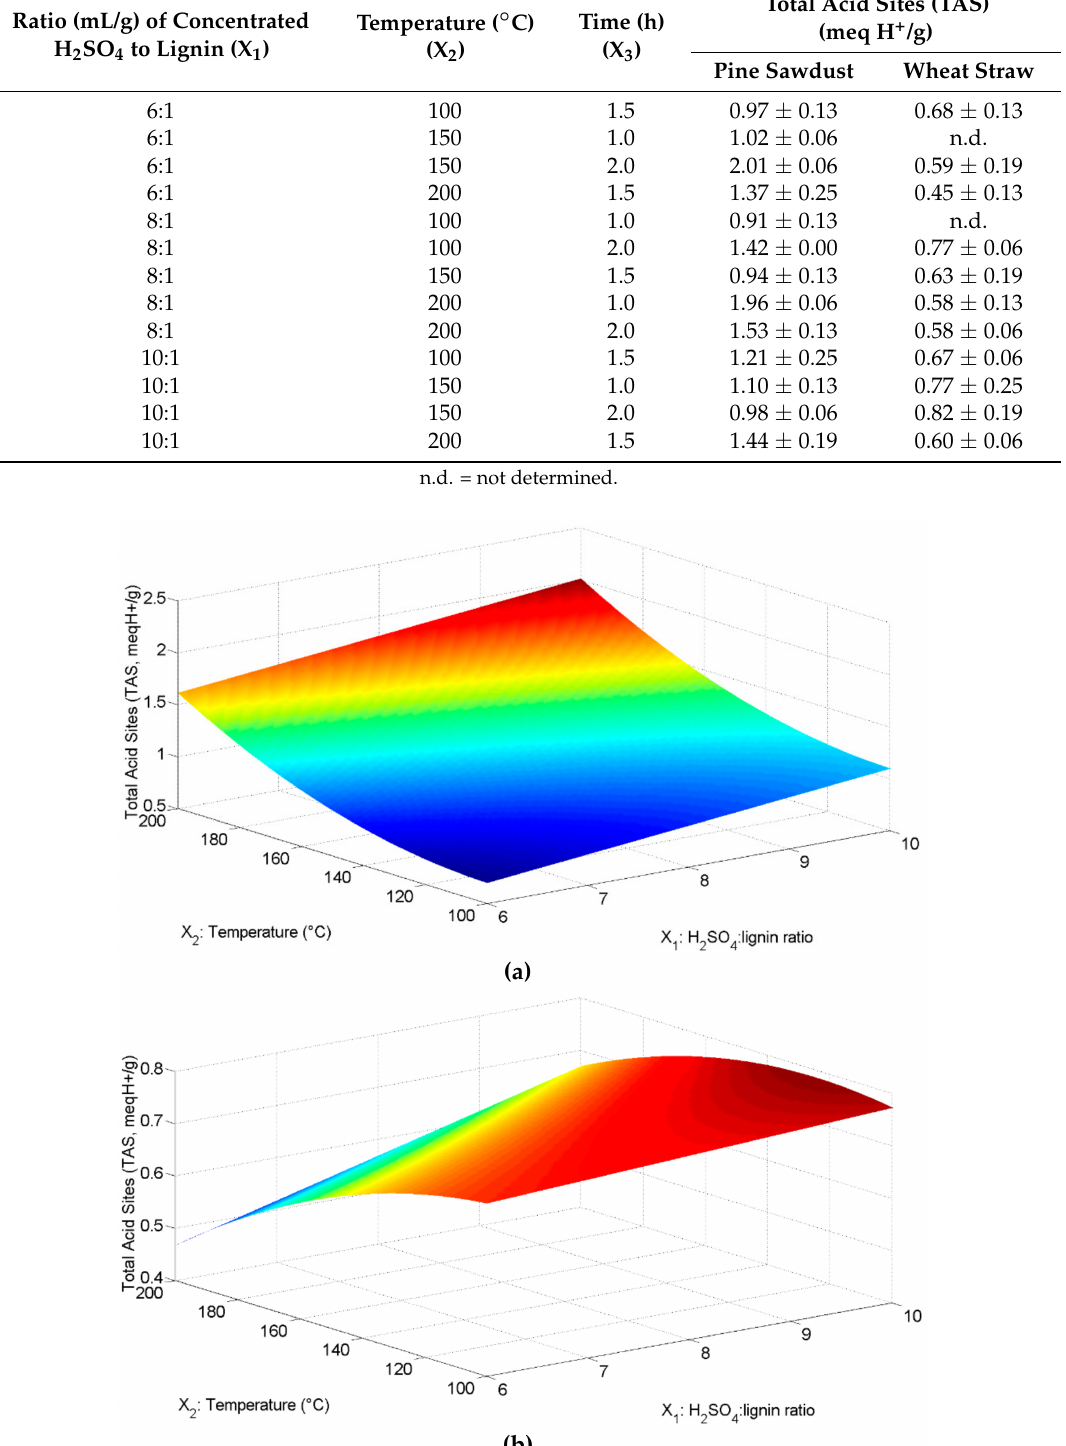
Ratio (mL/g) of Concentrated H 2 SO 4 to Lignin (X 1 )